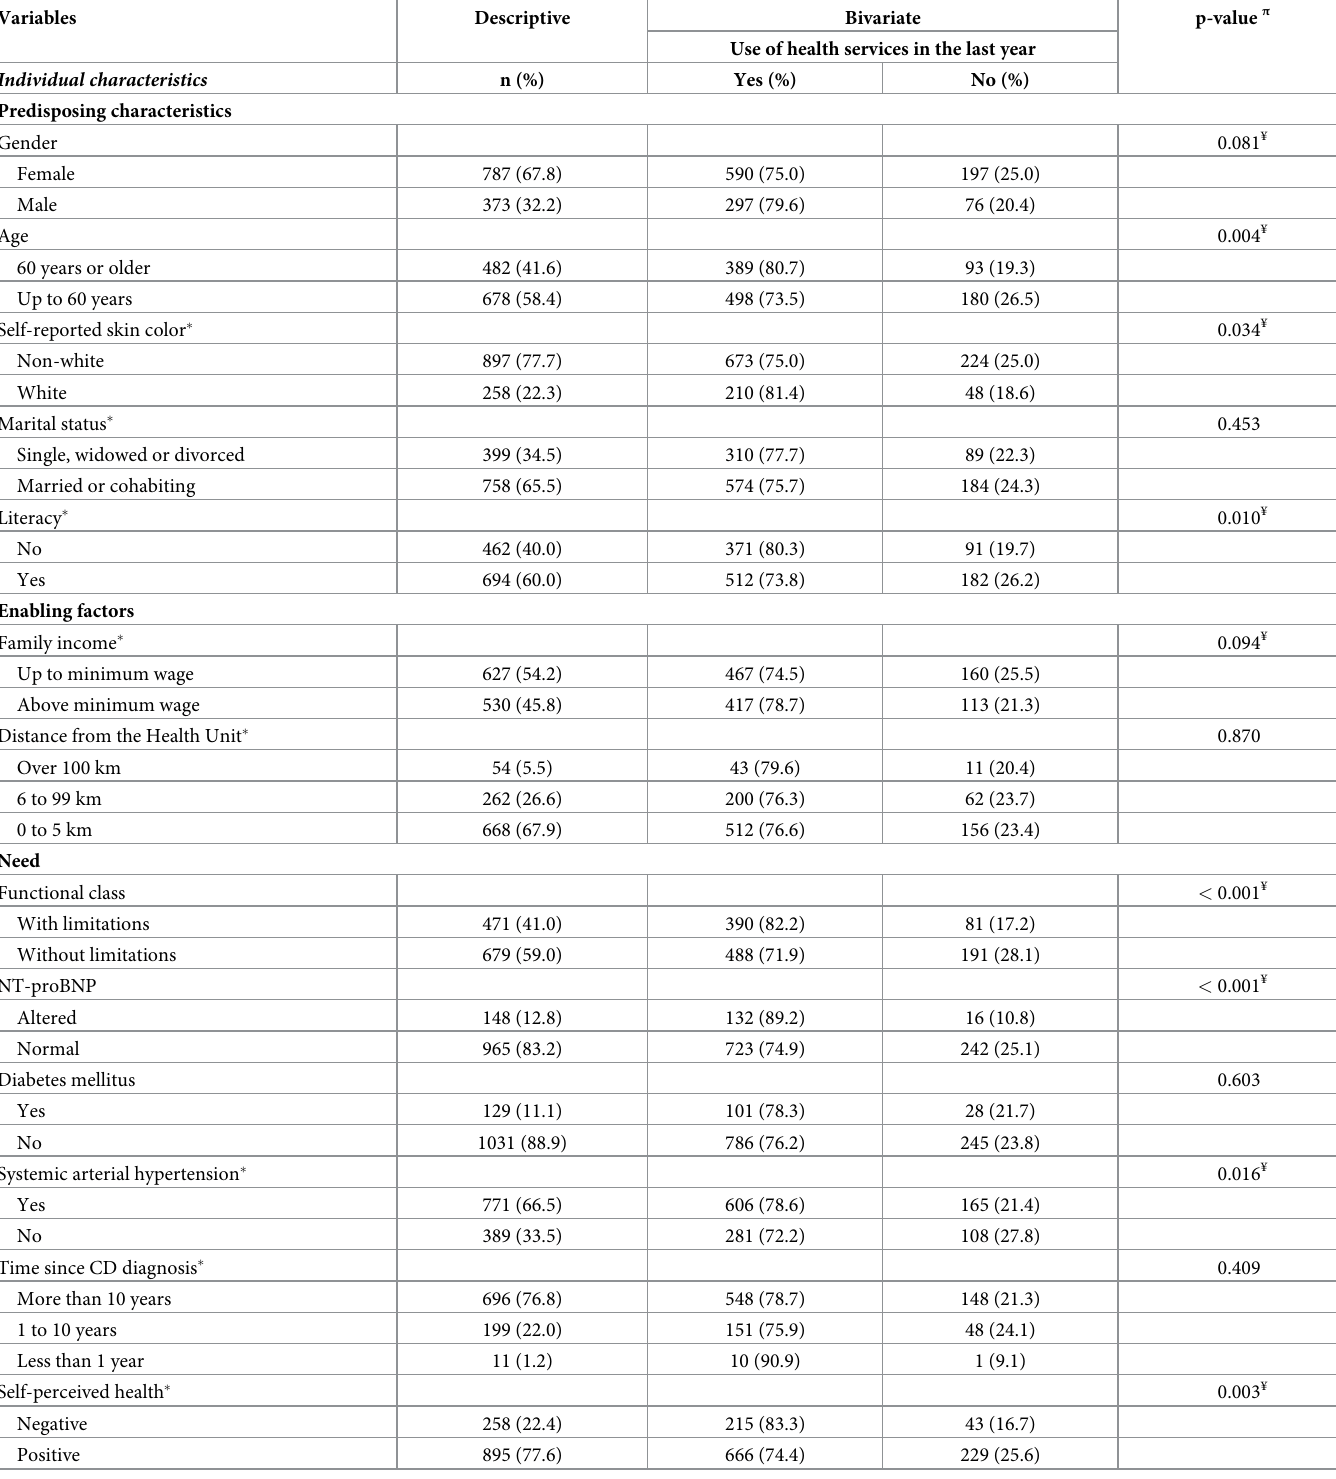
Table 2. Descriptive and bivariate analysis of individual characteristics and health behaviors of people with Chagas disease and its association with not using health services in the last year. Minas Gerais, Brazil (n =